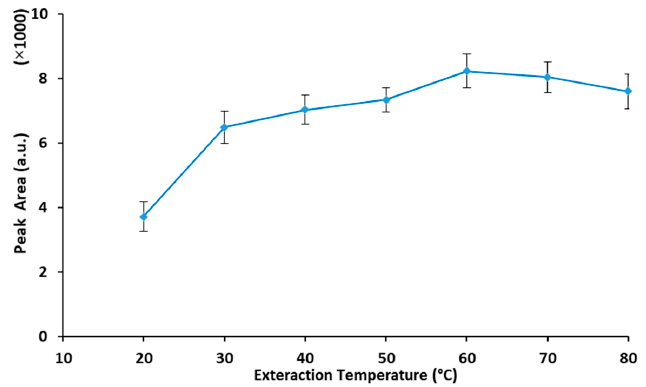
Figure 4. Extraction temperature vs. extraction efficiency of MTBE (analyte concentration: 2 µg·g − 1 , extraction time: 15 min, desorption condition: 2 min at 250 °C).